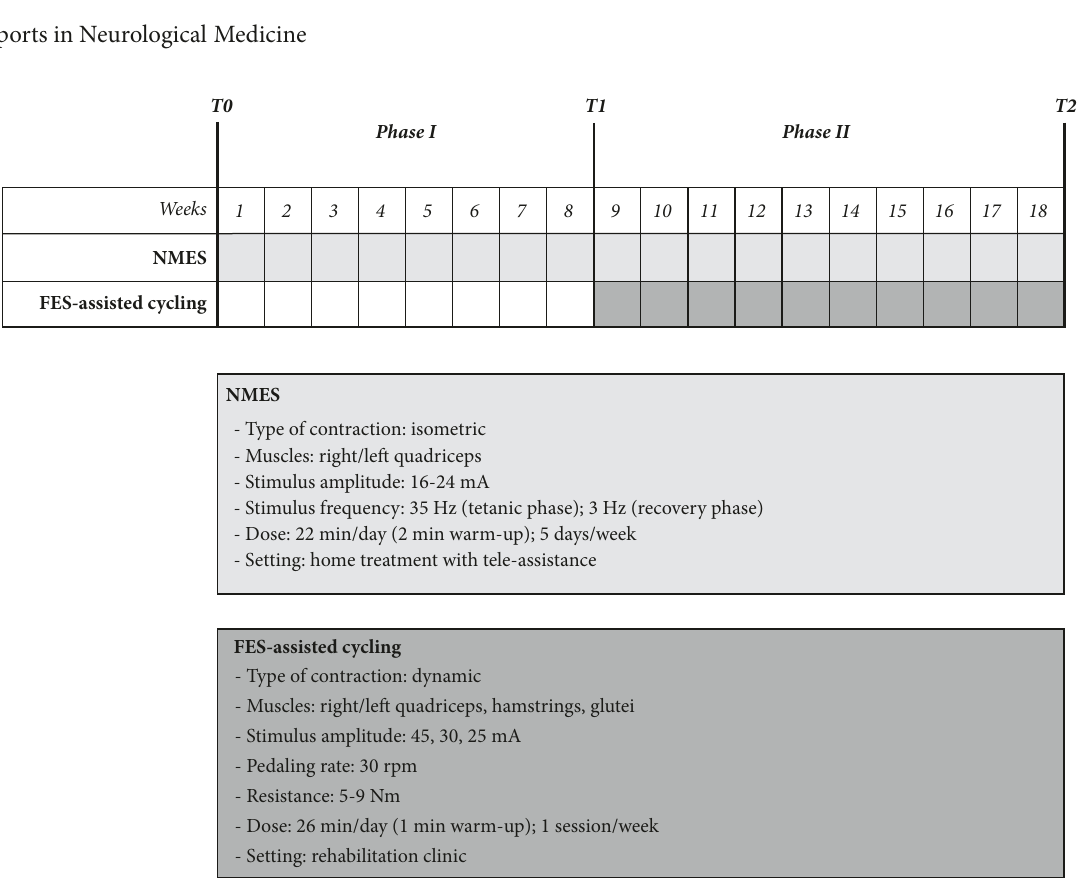
Figure 1: Timeline of the program and description of the interventions. NMES=neuromuscularelectricalstimulation; FES=functional electrical stimulation; T0=baseline (beginning of Phase I); T1=after 8 weeks of treatment (end of Phase I; beginning of Phase II); and T2=end of treatment (end of Phase